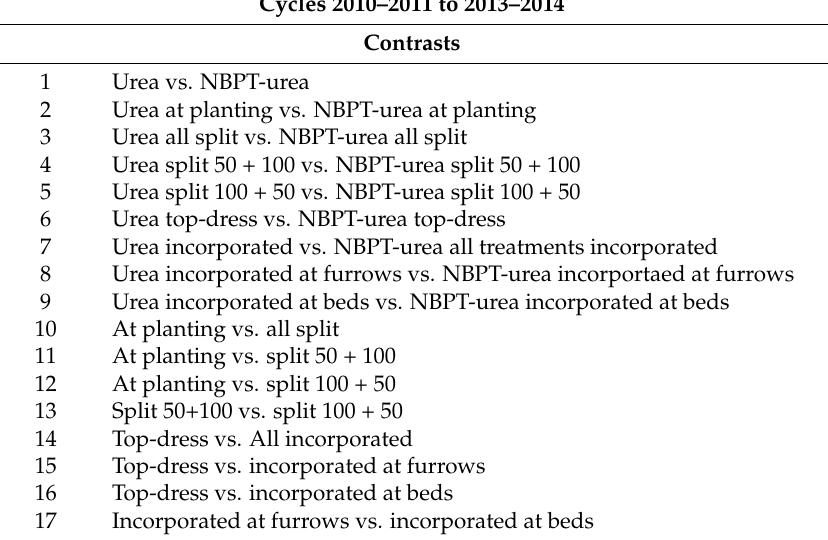
Table 3. Selected contrasts to compare the effects on wheat yield, grain and straw nitrogen concentration, agronomic efficiency of N (AE N ), N recovery efficiency (RE N ), and N physiological efficiency (PE N ), as influenced by selected treatments composed of urea sources, timing and methods of fertilizer application at the International Maize and Wheat Improvement Center (CIMMYT), in the Yaqui valley, near Ciudad Obregon, Sonora,